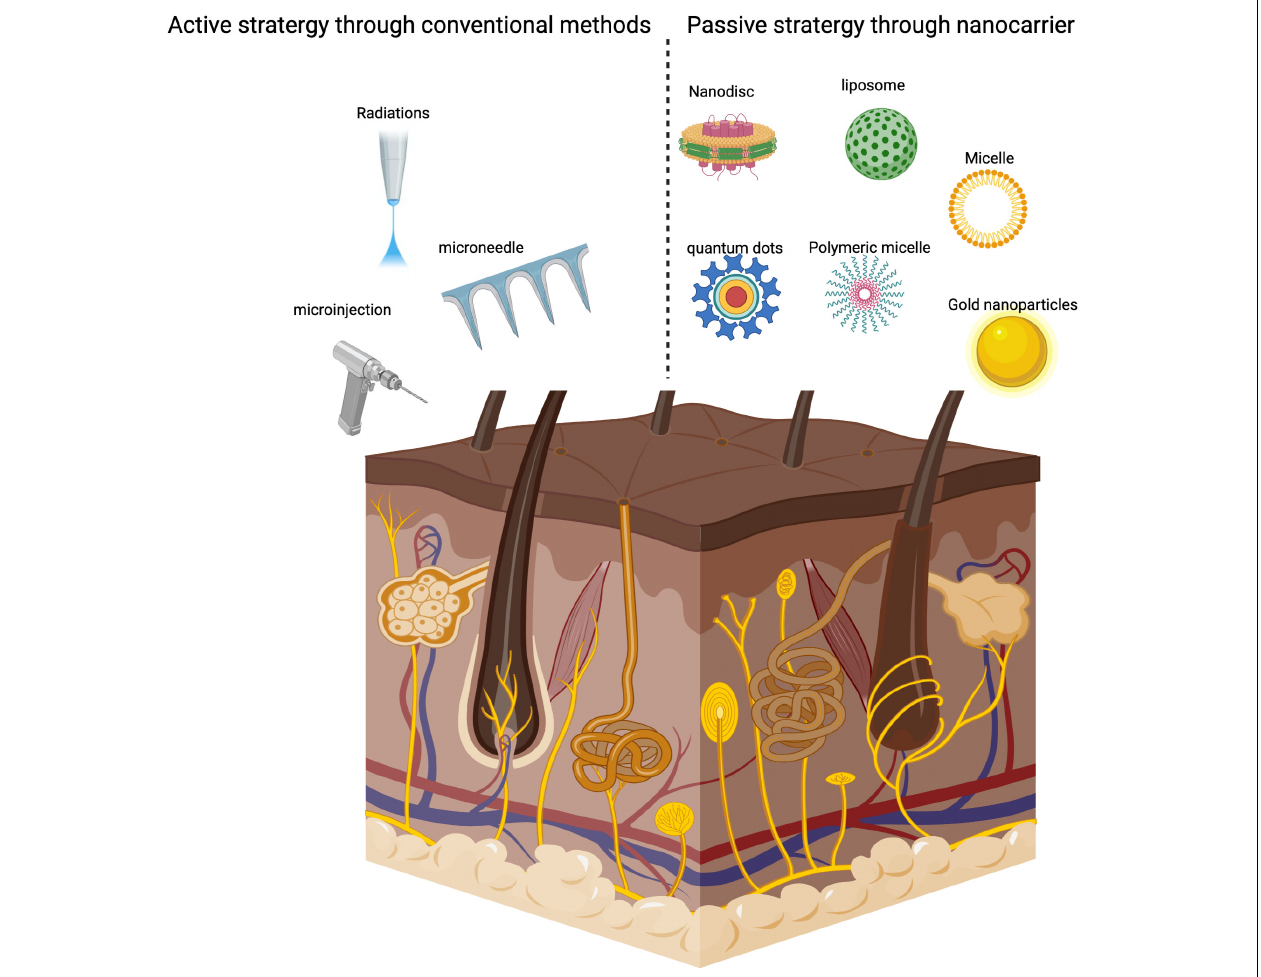
FIGURE 3 | Drug delivery strategy of Nanocarriers and conventional